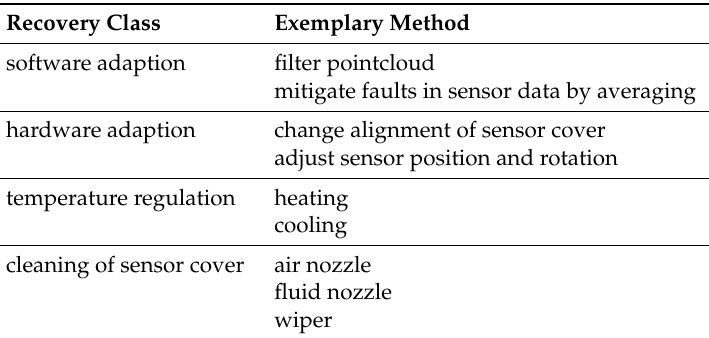
Table 3. Classification of fault recovery methods for perception sensors including exemplary